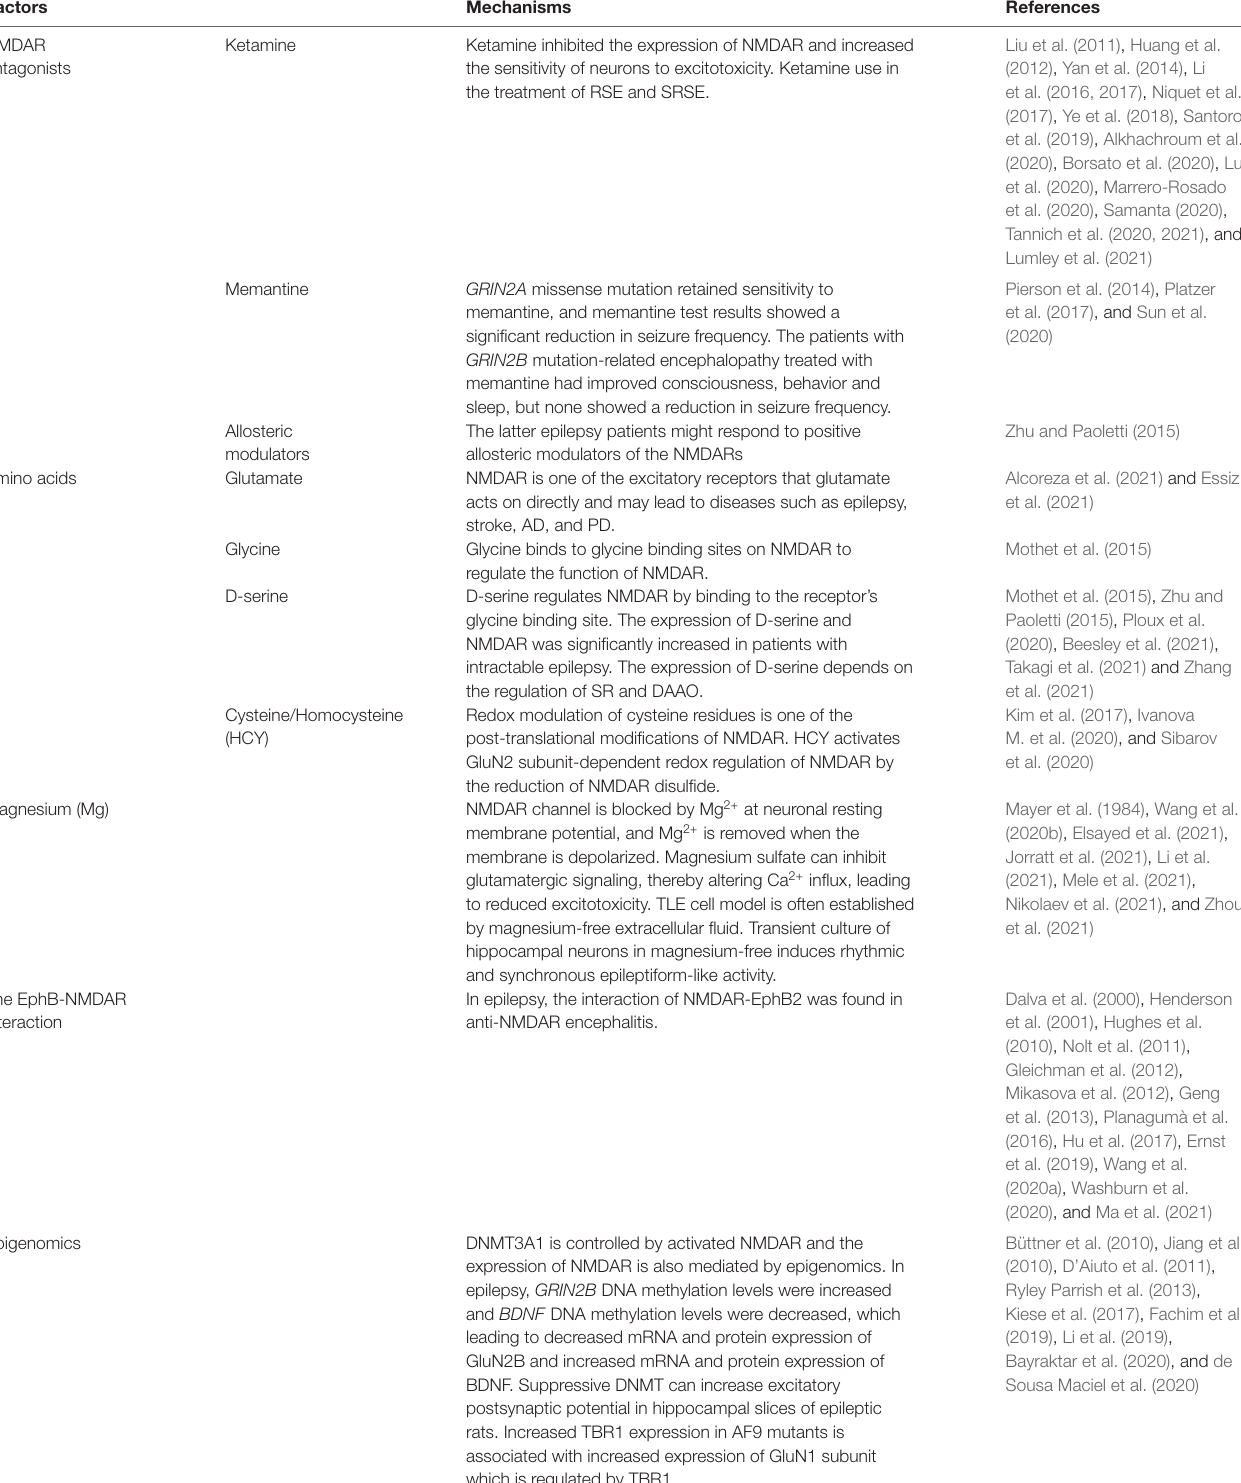
TABLE 1 | The regulation of NMDAR in